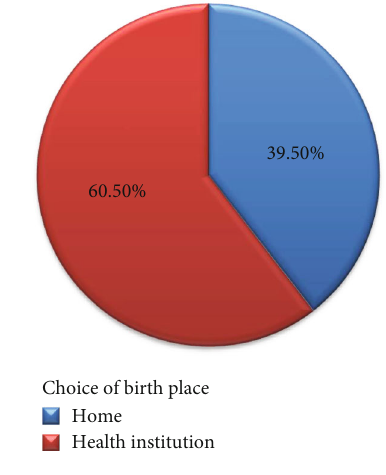
Figure 3: Maternal choice of delivery place in Jimma Arjo District, Oromia, Ethiopia, 2018.